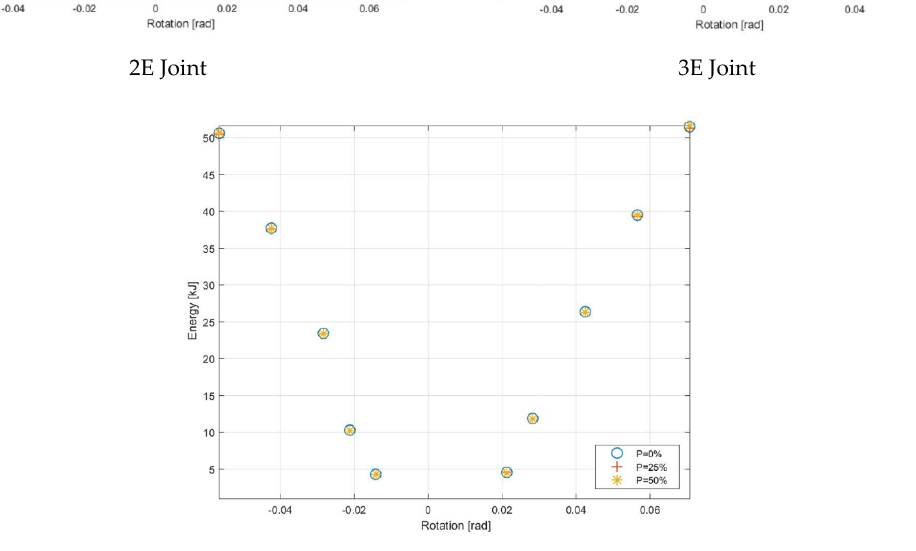
Figure 15. Summary of Dissipated Energy vs. Rotation according to equivalent load-displacement Method.